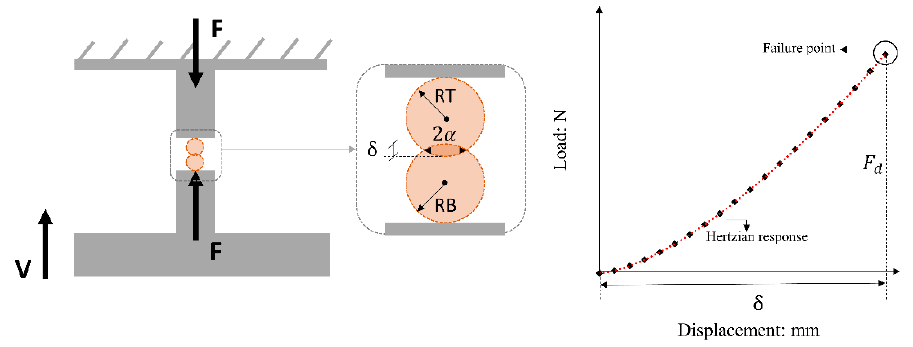
Figure 1. Schematic representation of crushing test setup and representative force—displacement curve.